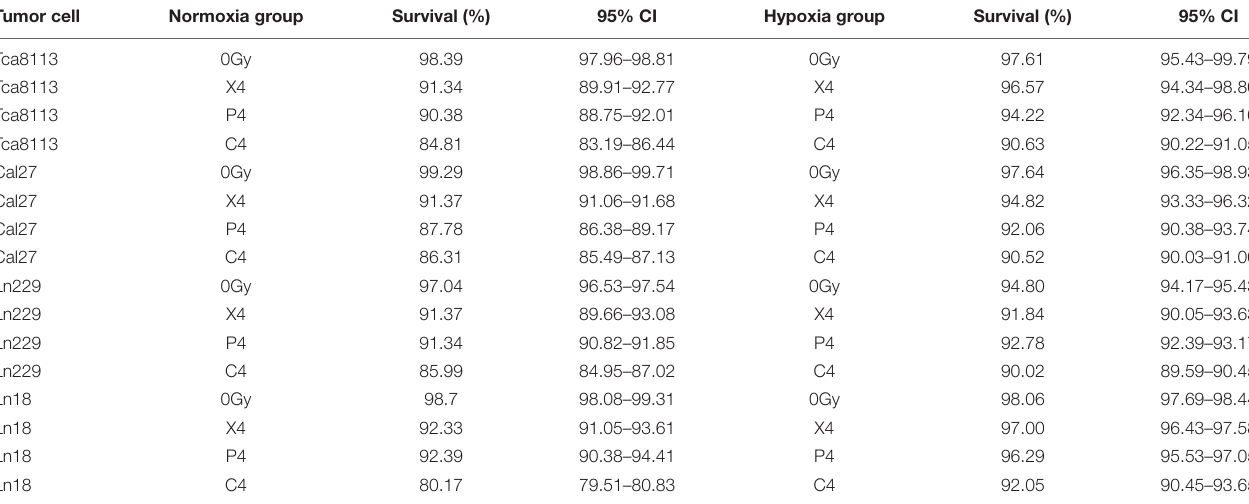
TABLE 2 | The percentage of viable tumor cells in each group 48 h after irradiation under normoxia and hypoxia. Tumor